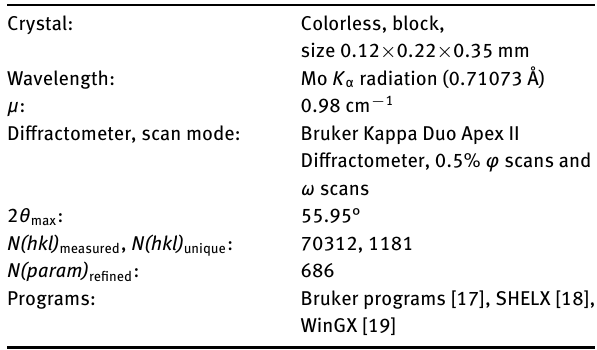
Table 1: Data collection and handling.